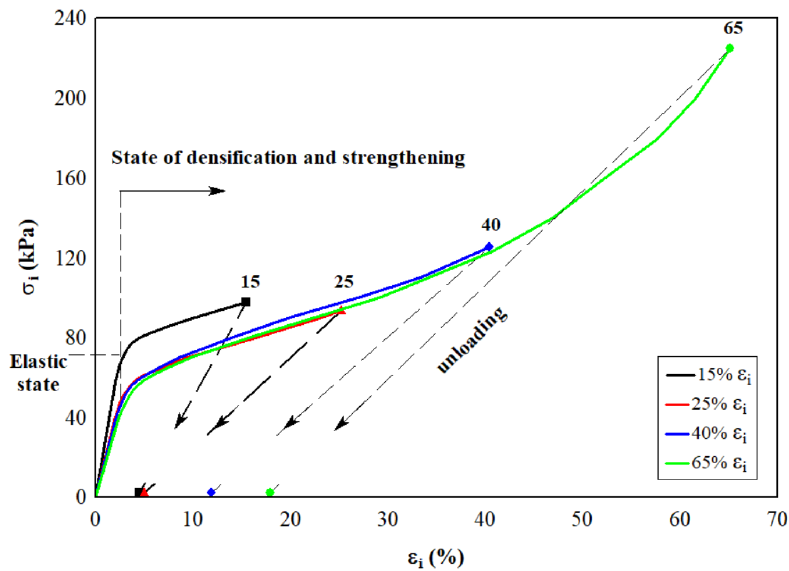
Figure 2. The elastic–plastic behavior of EPS with a density of 14–18 kg/m 3 at short-term compression. Points along the x -axis are experimental values of residual strain after full unloading of the EPS specimens.